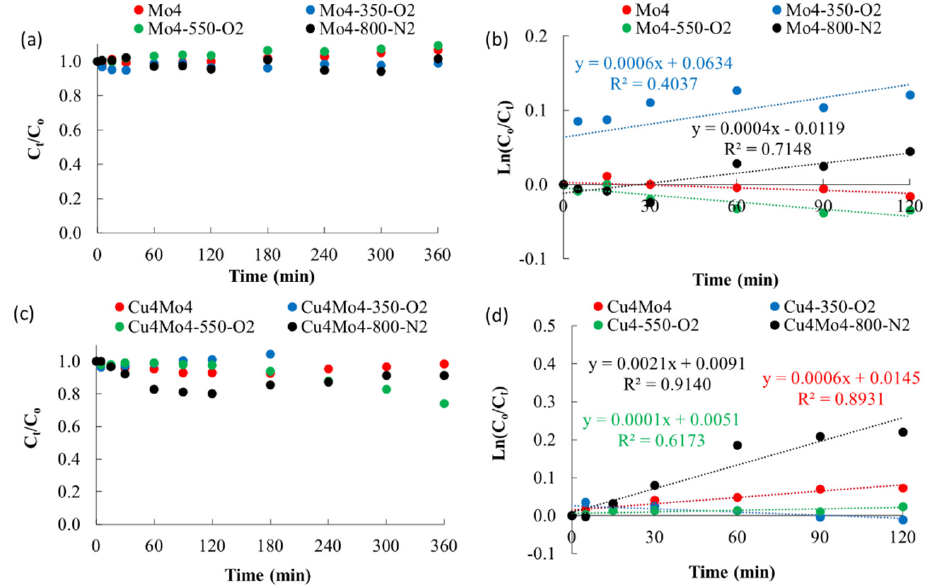
Figure 8. ( a , c ) Concentration decay curves of Y5 photodegradation using Mo and CuMo photocatalysts. ( b , d ) Linear regressions of the kinetic data from ( a , c ). Initial concentration, 5 ppm of Y5 dye.